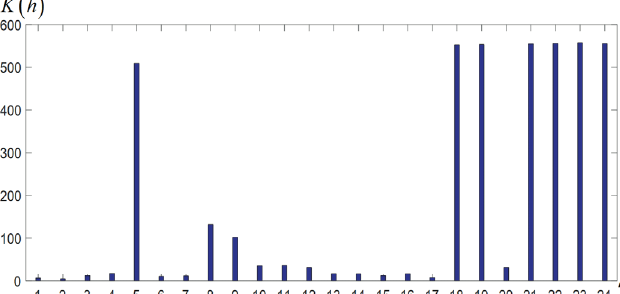
Fig. 1. The number of global TWT minima given by the heuristics versus the number of jobs to be scheduled (per 1000 instances).